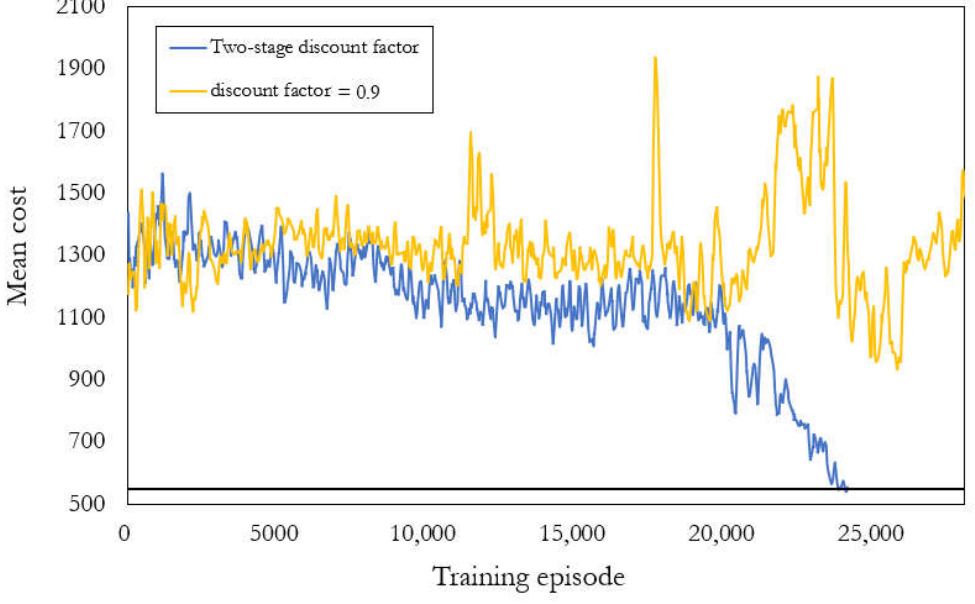
Figure 6. Mean costs for the last 100 training episodes for the two-stage discount factor (blue) and discount factor = 0.9 (yellow).